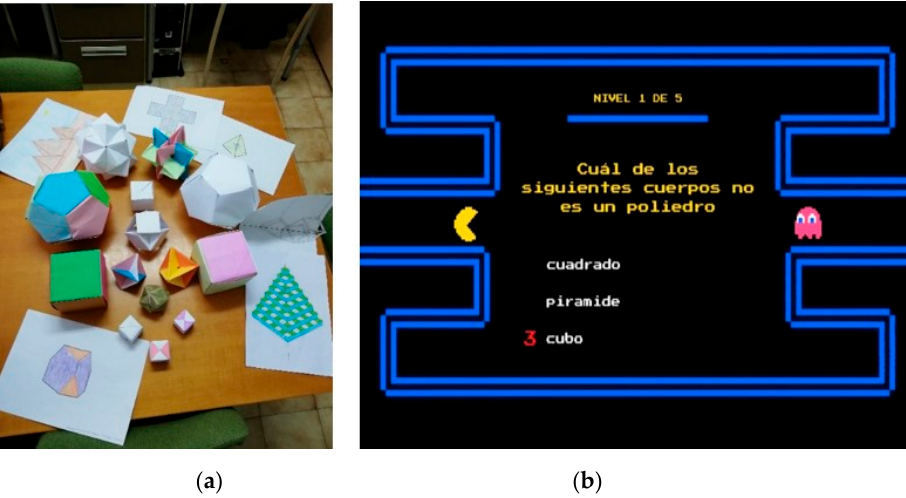
Figure 9. Polyhedral game “who’s who”. Own elaboration.